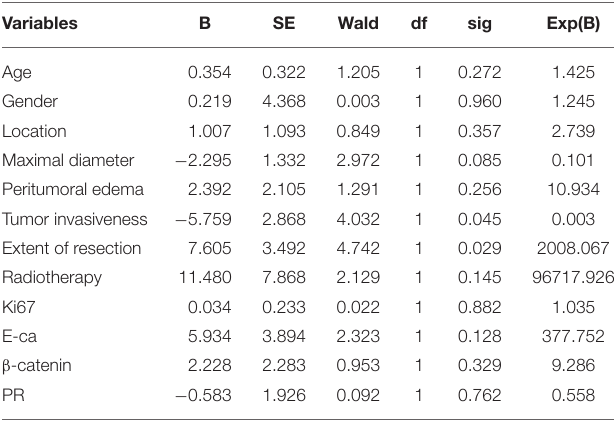
TABLE 3 | Multivariate analysis of factors related to the post-operative recurrence in AM patients.